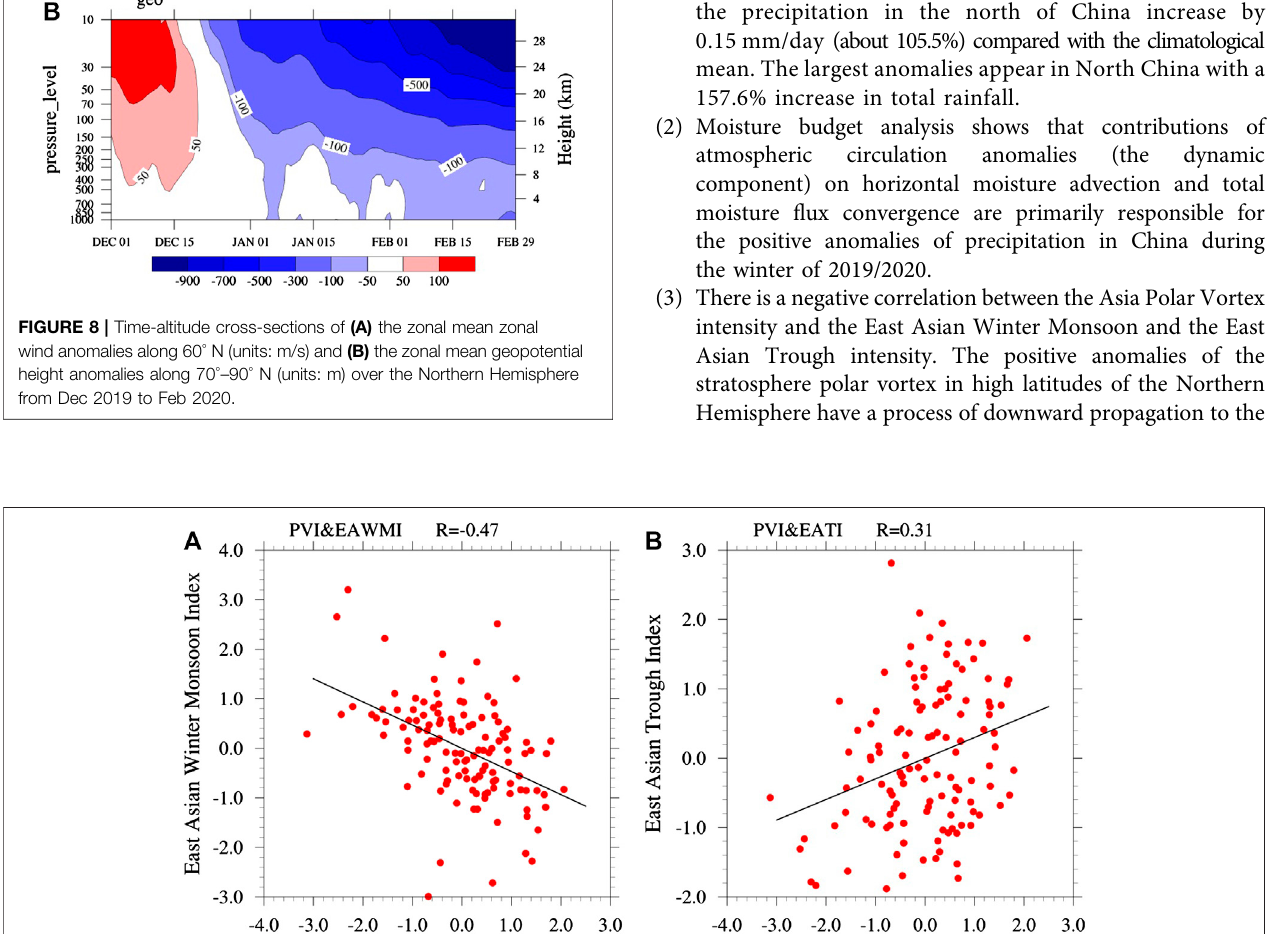
Frontiers in Earth Science |